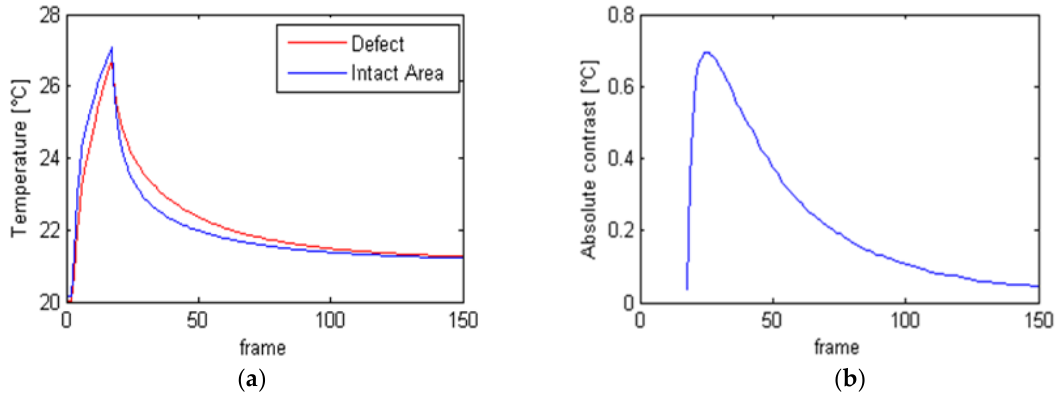
Figure 11. ( a ) Thermal profiles on multi-stringer component on right side of impact and ( b ) absolute contrast curve for delaminations with respect to intact area, using heating time of 7 s.